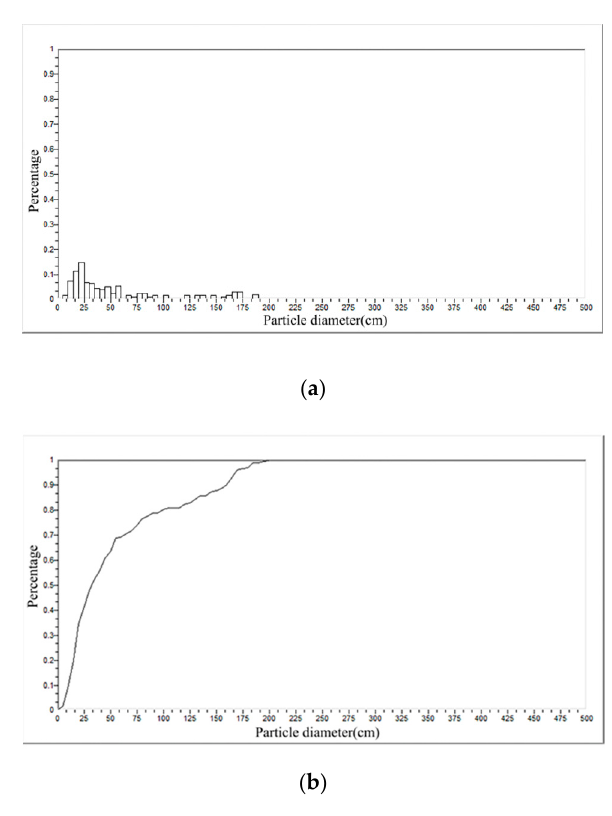
Figure 8. Histogram of blast comprehensive evaluation.